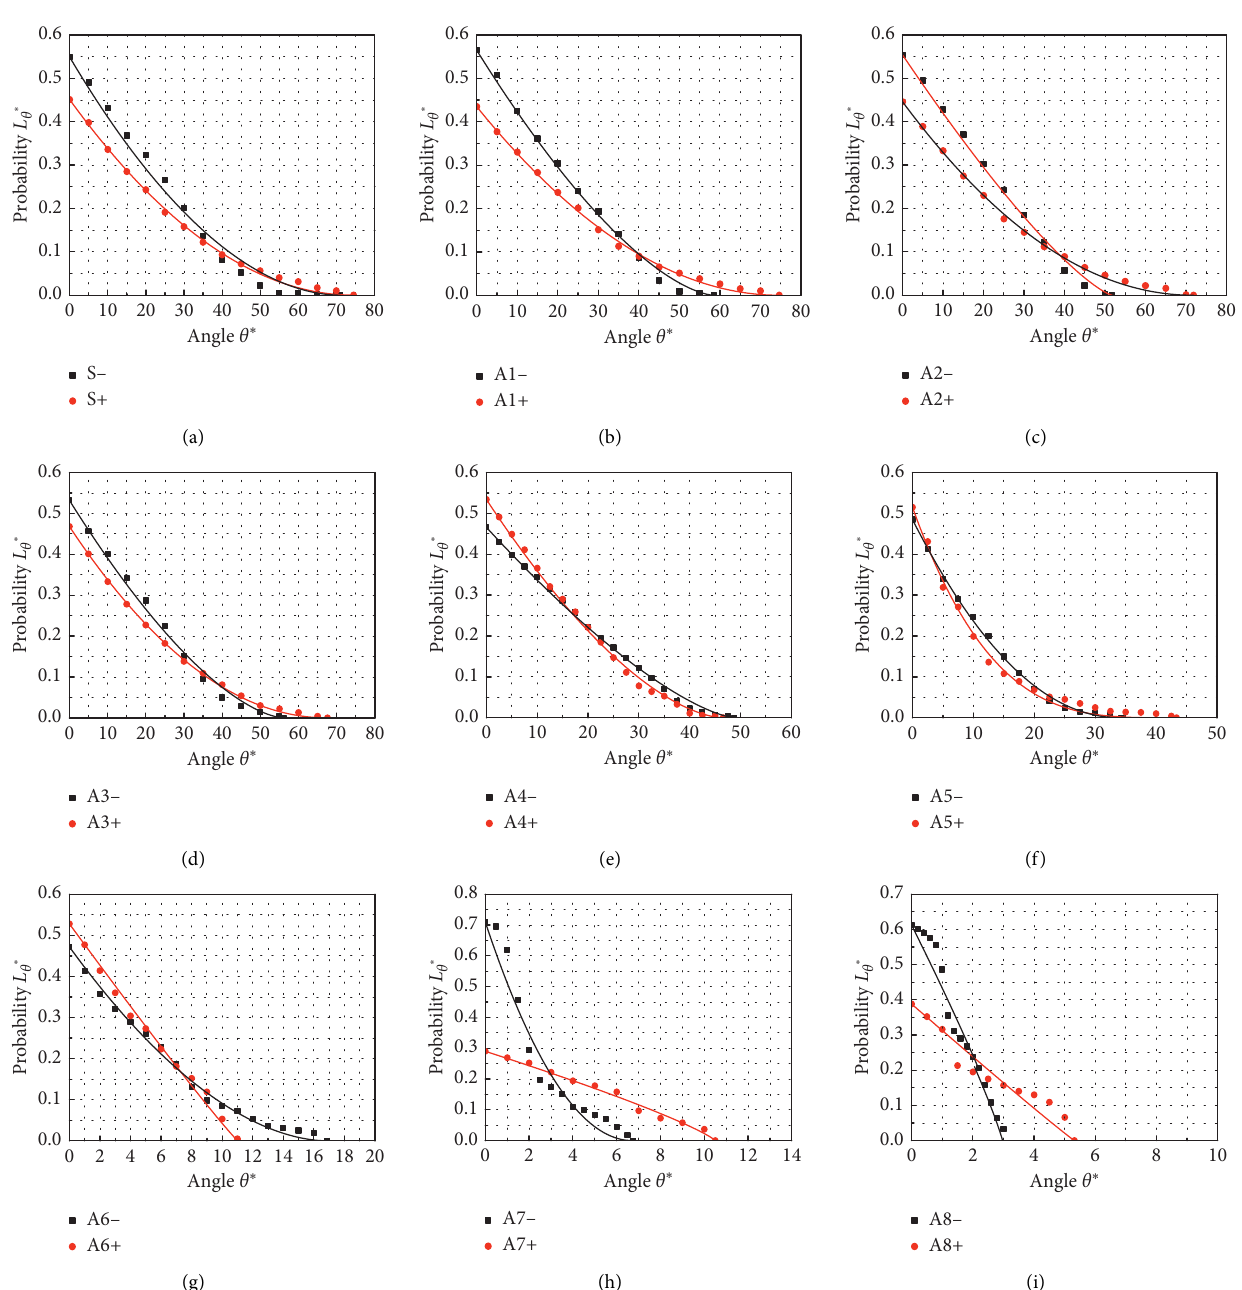
Figure 10: Angle probability distribution and fitting curve of rough fracture profile under different decomposition levels. (a) Original. (b) Level 1. (c) Level 2. (d) Level 3. (e) Level 4. (f) Level 5. (g) Level 6. (h) Level 7. (i) Level